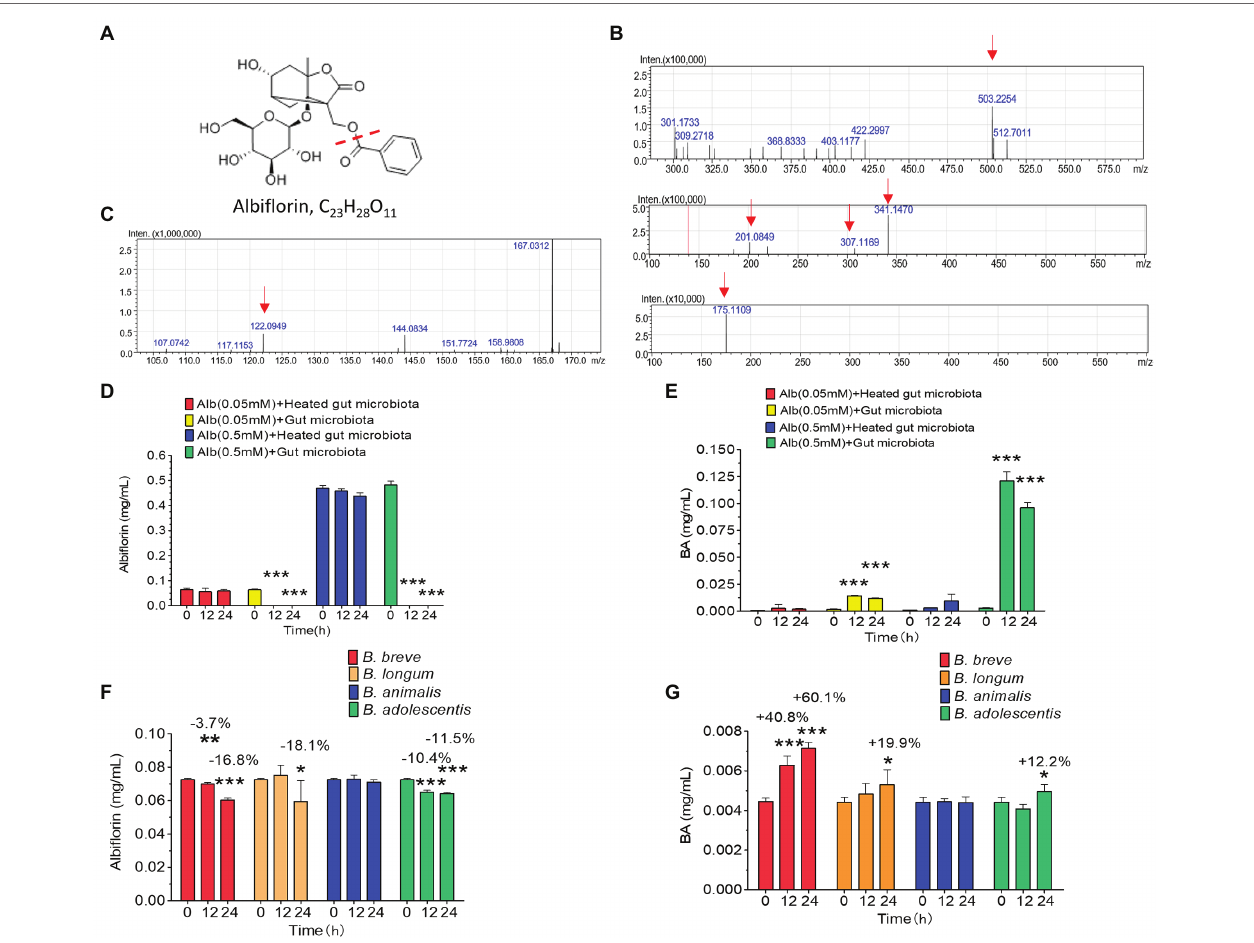
FIGURE 1 | The intestinal microbes of rats converted albiflorin into benzoic acid. (A) Schematic diagram of the structure of albiflorin and benzoic acid. (B) High- resolution mass spectrum of albiflorin. (C) High-resolution mass spectrum of benzoic acid. (D) Conversion of albiflorin by the intestinal microbes of rats. (E) Benzoic acid (BA) generated by the intestinal microbes of rats. (F) Conversion of albiflorin in the four Bifidobacteria strains. (G) Benzoic acid (BA) generated by the four Bifidobacteria strains. (Student’s t -test, * p < 0.05, ** p < 0.01, and *** p < 0.001, data are expressed as the mean ±